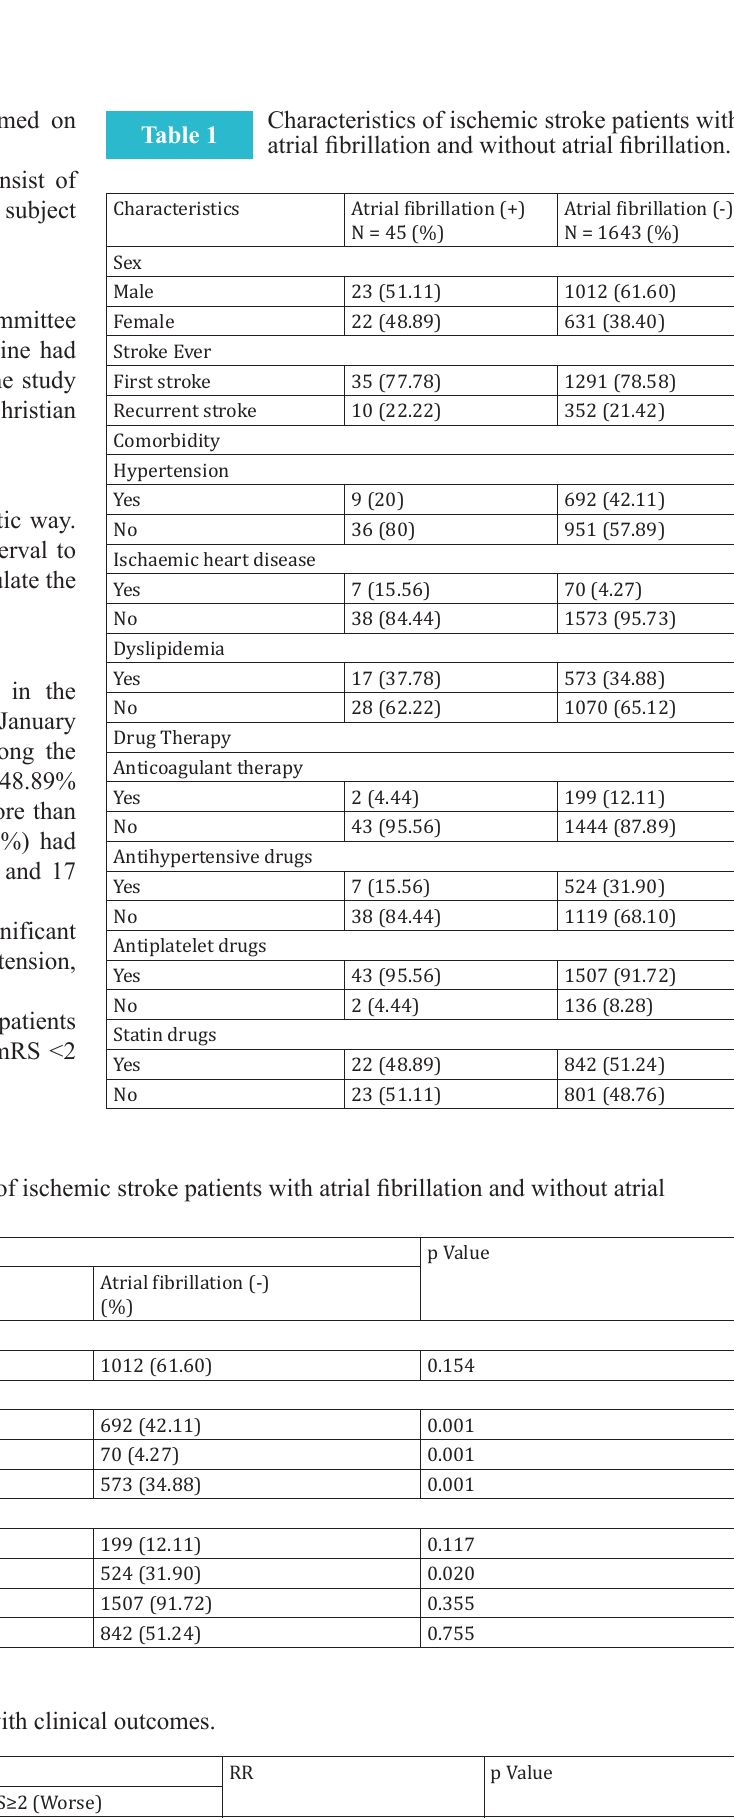
Characteristics of ischemic stroke patients with atrial fibrillation and without atrial fibrillation. Table 1